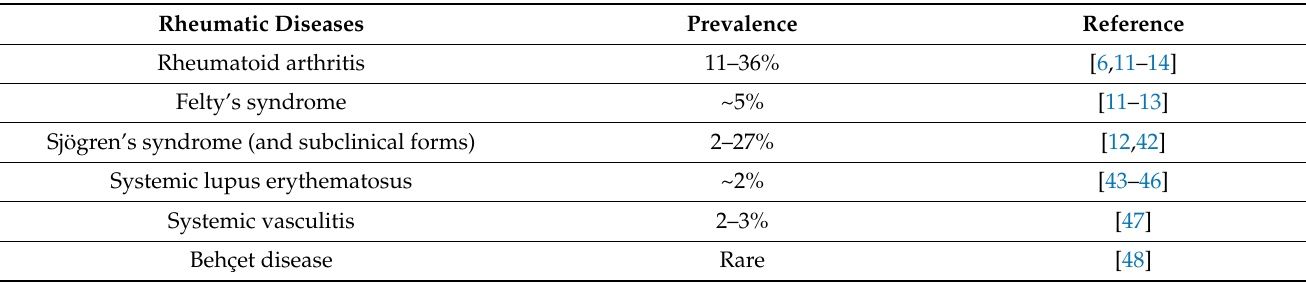
Table 2. List of autoimmune conditions and prevalence of the association with